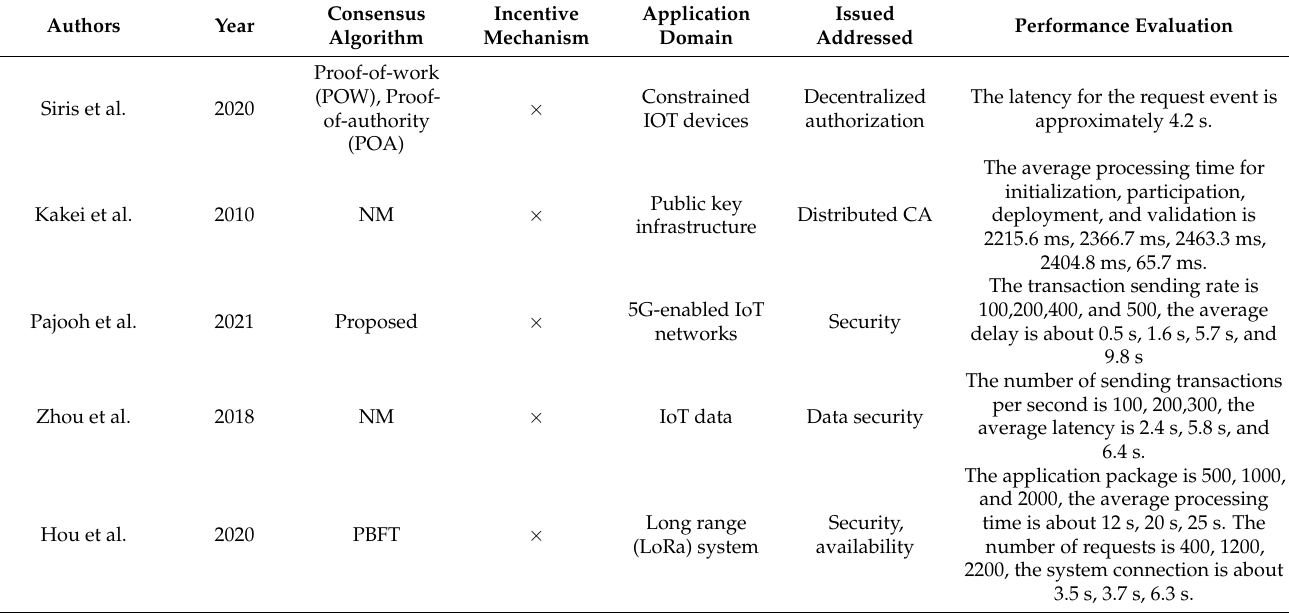
Table 3. Differences between IoT security schemes (continue Tables 1 and